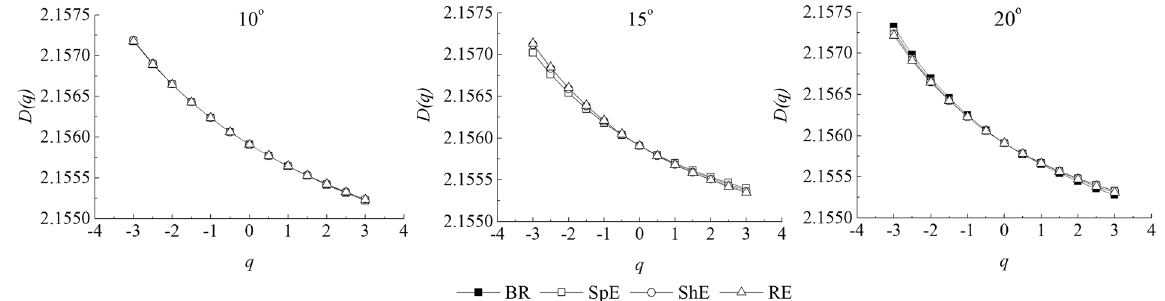
Figure 4. Relationship between D ( q ) and q of surface elevation at different erosive stages on different slope